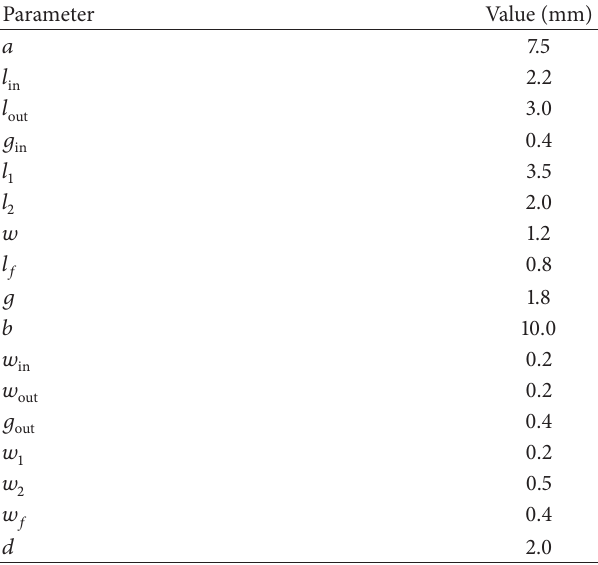
Table 1: The geometric parameters of the proposed filter